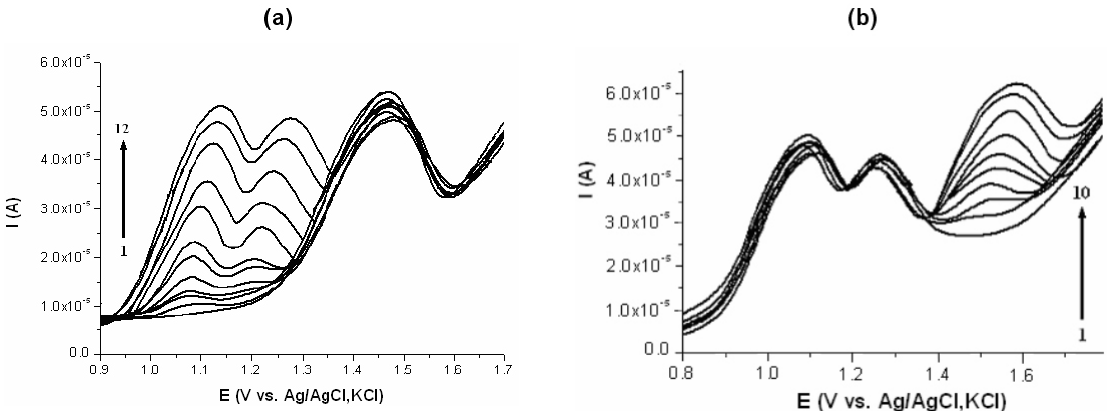
Figure 6. Differential pulse voltammograms on electrochemically activated glassy carbon electrode for (a) a 10 -3 mol L -1 caffeine solution in the presence of different codeine phosphate concentrations: (1) 0, (2) 5×10 -7 , (3) 10 -6 , (4) 5×10 -6 , (5) 10 -5 , (6) 5×10 -5 , (7) 7.5×10 -5 , (8) 10 -4 , (9) 2.5×10 -4 , (10) 5×10 -4 , (11) 7.5×10 -4 , (12) 10 -3 mol L -1 , in acetate buffer pH 4.5 and (b) a 10 -3 mol L -1 codeine phosphate solution in the presence of different caffeine concentrations: (1) 0, 10 -6 (2), (3) 5·10 -6 , (4) 10 -5 , (5) 5×10 -5 , (6) 10 -4 , (7) 2.5×10 -4 , (8) 5×10 -4 , (9) 7.5×10 -4 , (10) 10 -3 mol L -1 , in acetate buffer pH 4.5 (reference electrode Ag/AgCl; auxiliary electrode Pt wire; scan rate 0.04 V s -1 ; amplitude 100 mV; modulation time 5 ms; 20 o